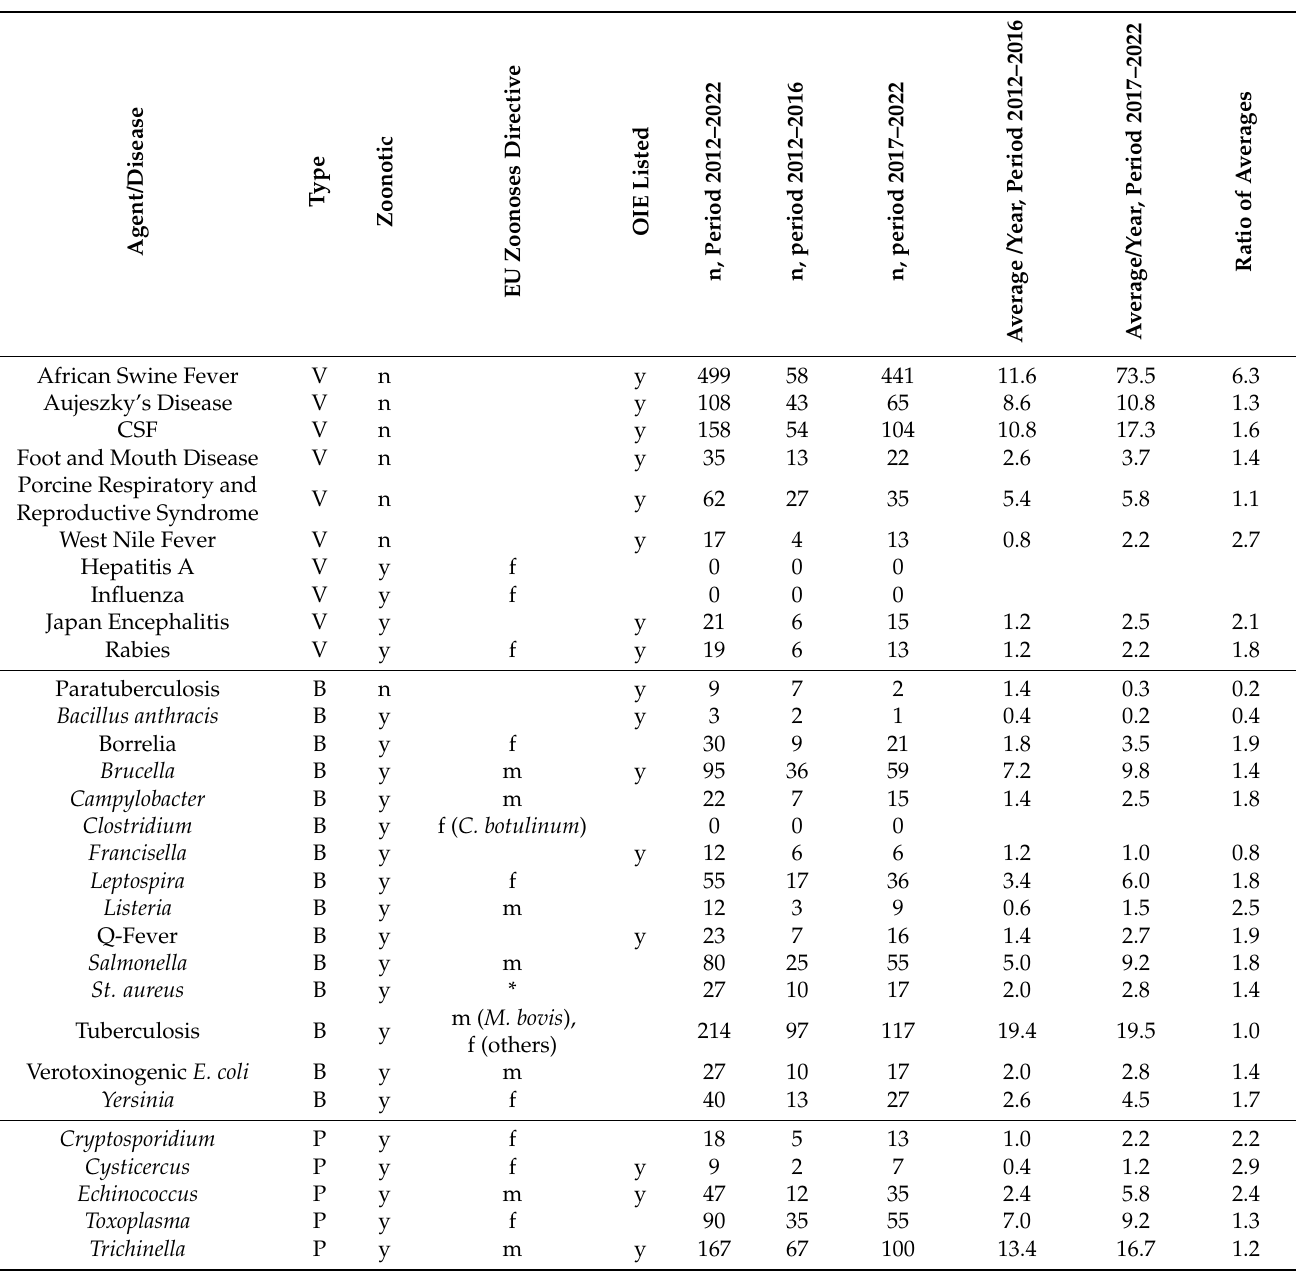
Table 1. Agents or diseases of wild boar covered in the literature survey (2012–2022), their coverage in legislation, and the number of pertinent